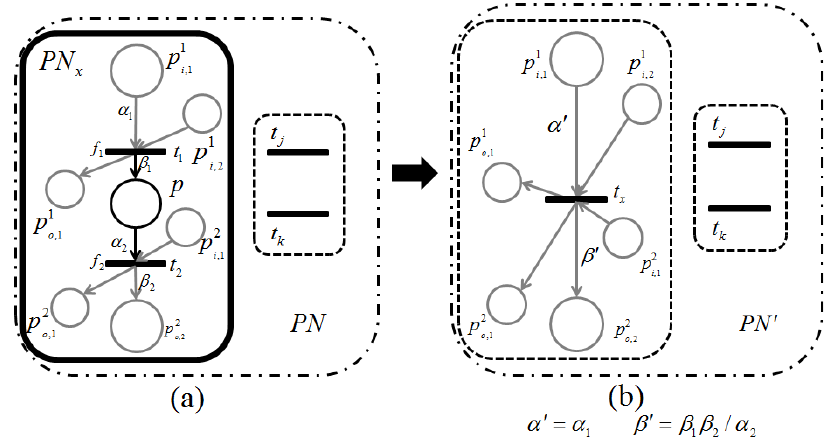
Figure 9. Shrink of a single-input and single-output structure. ( a ) before shrinking; ( b ) after shrinking.